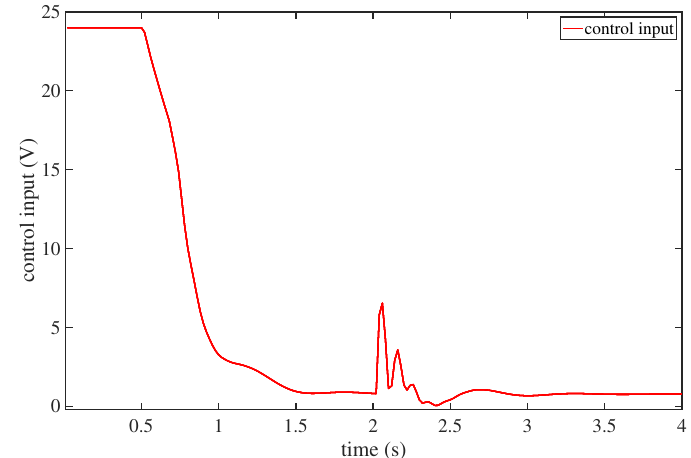
Figure 12. The control actions with external